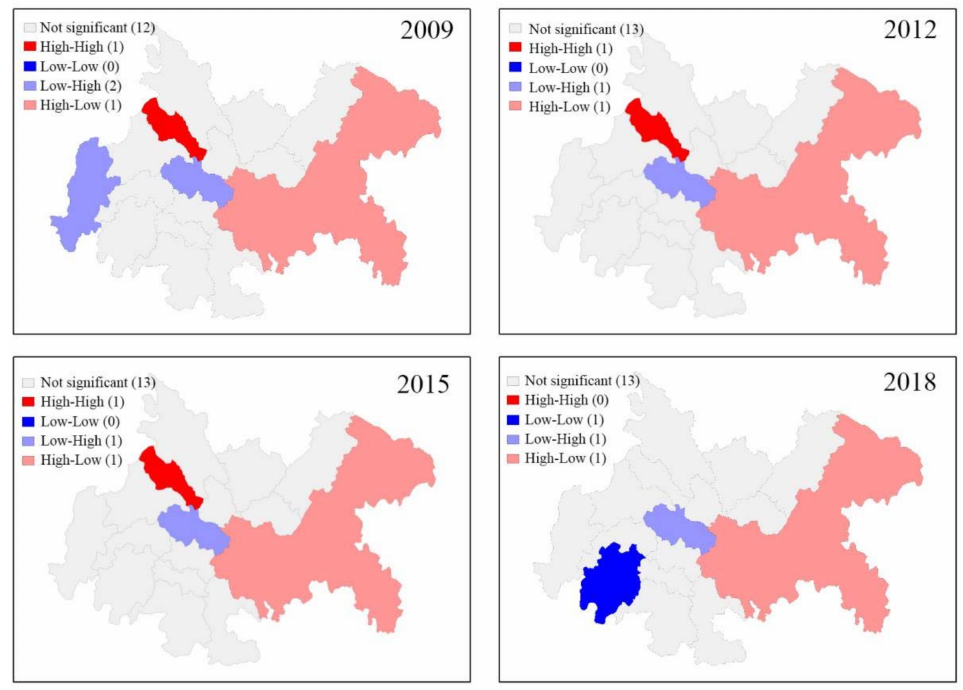
Figure 5. The LISA agglomeration map of 2009, 2012, 2015, and 2018.